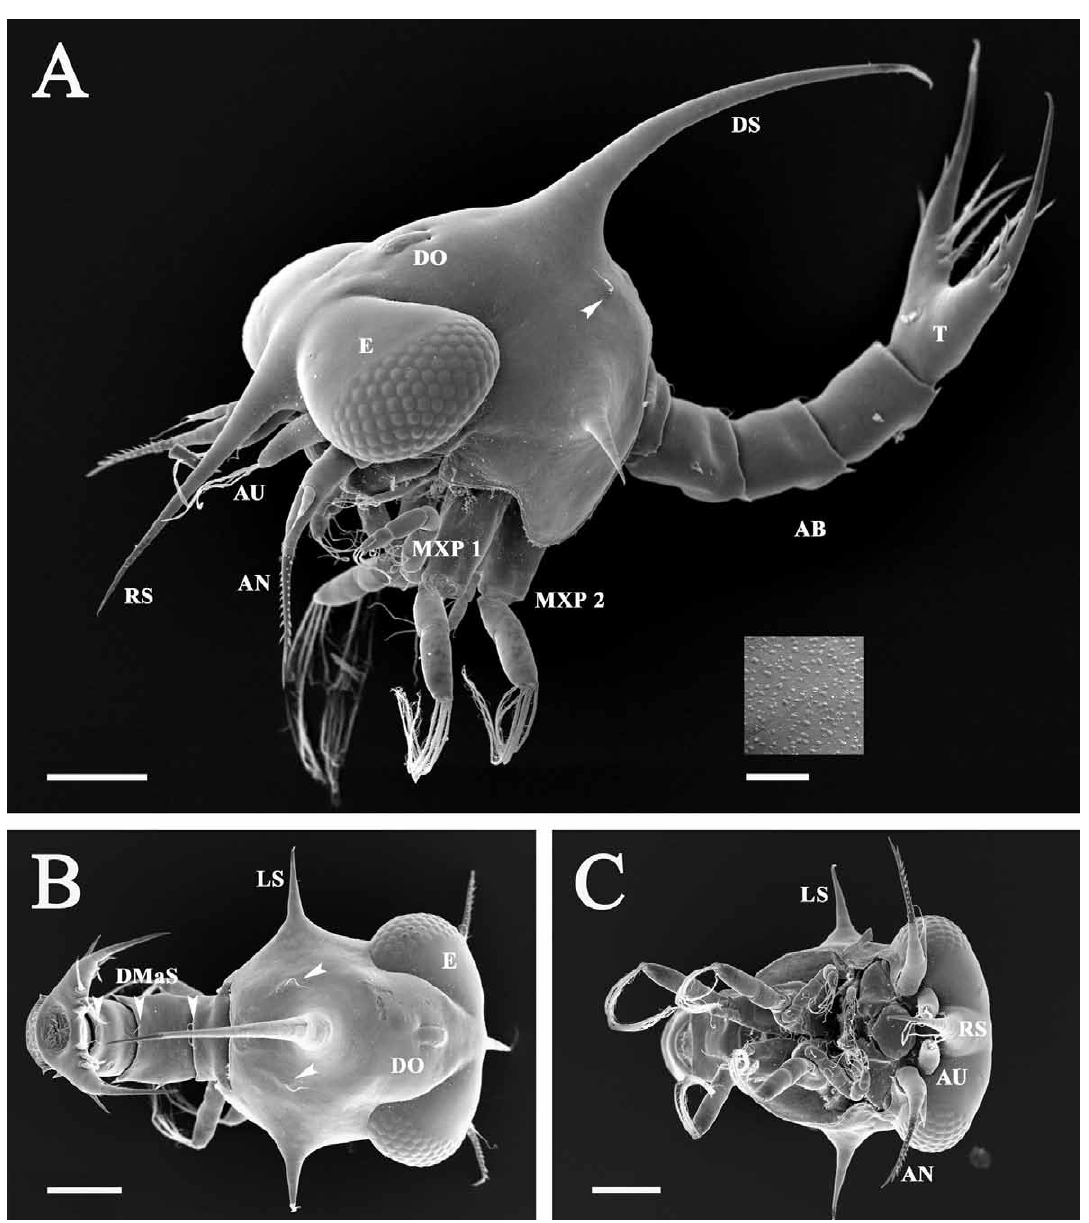
process with 8 marginal